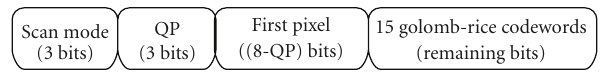
Figure 4: The format of a Golomb-Rice codeword